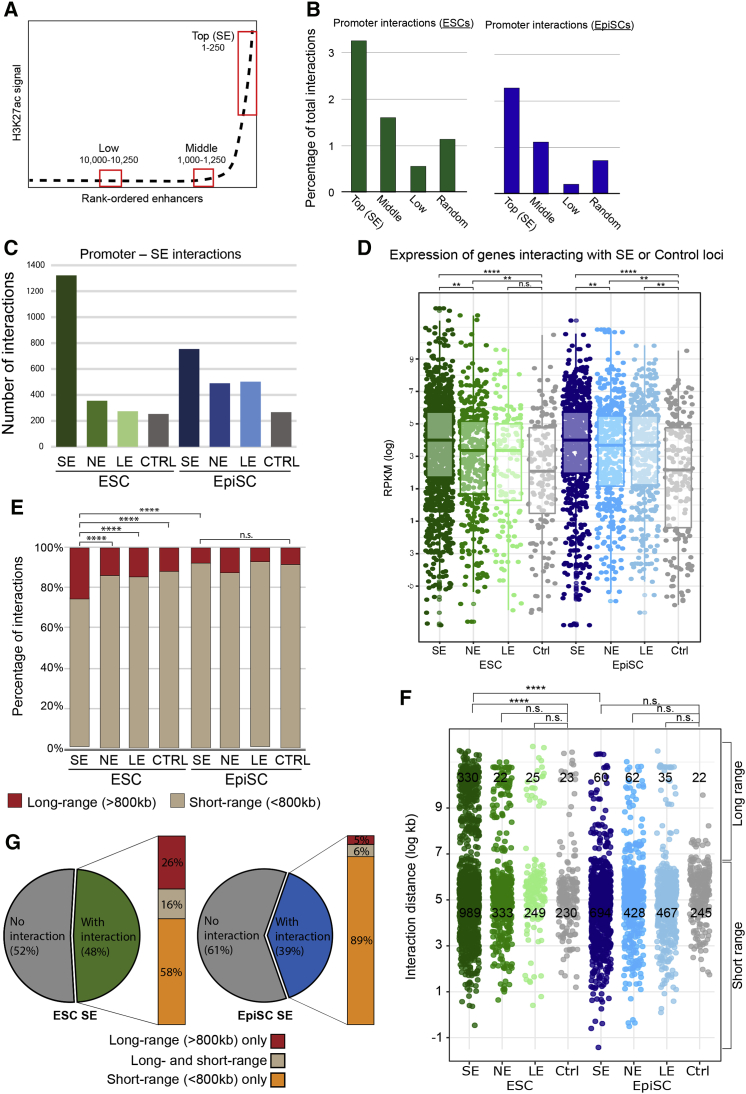
Long-Range Promoter-SE Interactions Are Prevalent in ESCs(A) After ROSE analysis, we selected three enhancer categories: the top 250 H3K27ac-ranked regions (comprising a subset of SEs), the first 250 enhancers immediately below the SE-threshold (middle), and 250 enhancers with low levels of H3K27ac. Red boxes highlight the selected enhancers within each category.(B) Proportion of PCHi-C interactions detected for the three enhancer categories and control regions in ESCs (left) and in EpiSCs (right). Control regions were randomly selected and size-matched to SEs.(C) Number of interactions after concatenation of the fragments spanning an individual SE, normal enhancer (NE), low enhancer (LE), or randomly selected control regions (CTRL) in ESCs and EpiSCs.(D) Expression (log2 reads per kilobase per million mapped reads [RPKM]) of genes interacting with the three classes of enhancers and control regions in ESCs and EpiSCs. ∗∗∗∗p < 0.0001; ∗∗p < 0.01 (Mann Whitney U test).(E) ESCs have a high proportion (25%) of promoter-SE interactions spanning >800 kb (red) when compared to interactions in EpiSCs or to size matched NEs and control regions (CTRL; Benjamini-Hochberg adjusted chi-square p < 0.0001).(F) A significant proportion of LRIs between promoters and SEs in ESCs (green, 25%) compared to EpiSCs (blue, 7%) or to size- and distance-match random control regions (light green, 13%; Benjamini-Hochberg adjusted p < 0.0001). NE and LE are not significantly different from controls. See Table S2 for a list of LRIs.(G) Classification of concatenated SE fragments according to the genomic distance of their target promoters. In ESCs, 58% of interacting SE regions only engage in short-range (<800 kb), 26% in long-range only (>800 kb), and 16% in both short- and long-range promoter interactions. In EpiSCs, most interacting SEs (89%) engage in short-range interactions only. Note that the proportion of interactive SE regions is likely to be underestimated due to the stringent statistical analysis applied to the concatenated regions, and also due to the inability to detect interactions when the baited promoter and SE are within neighboring HindIII fragments.See also Table S2.